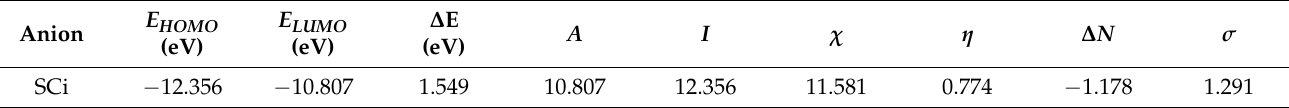
Figure 6. ( a ) Optimized molecular computed structure of citrate anion. Frontier molecular orbital density distribution of ( b ) HOMO (N = 36) and ( c ) LUMO (N = 37). Table 3. Quantum chemical parameters calculated for SCi anions.